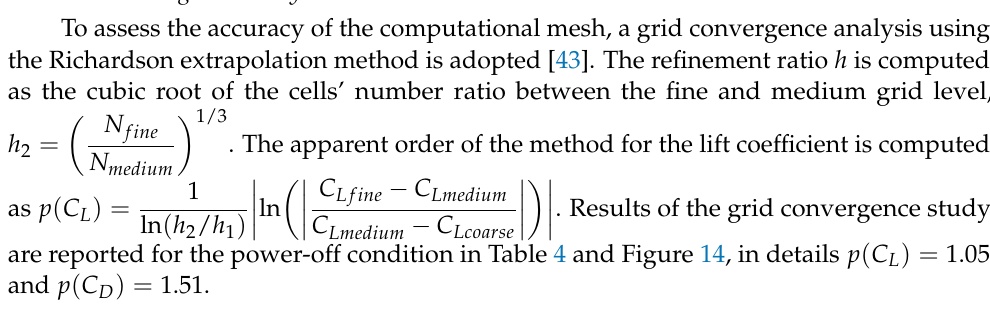
Table 4. Grid convergence for UZEN flow